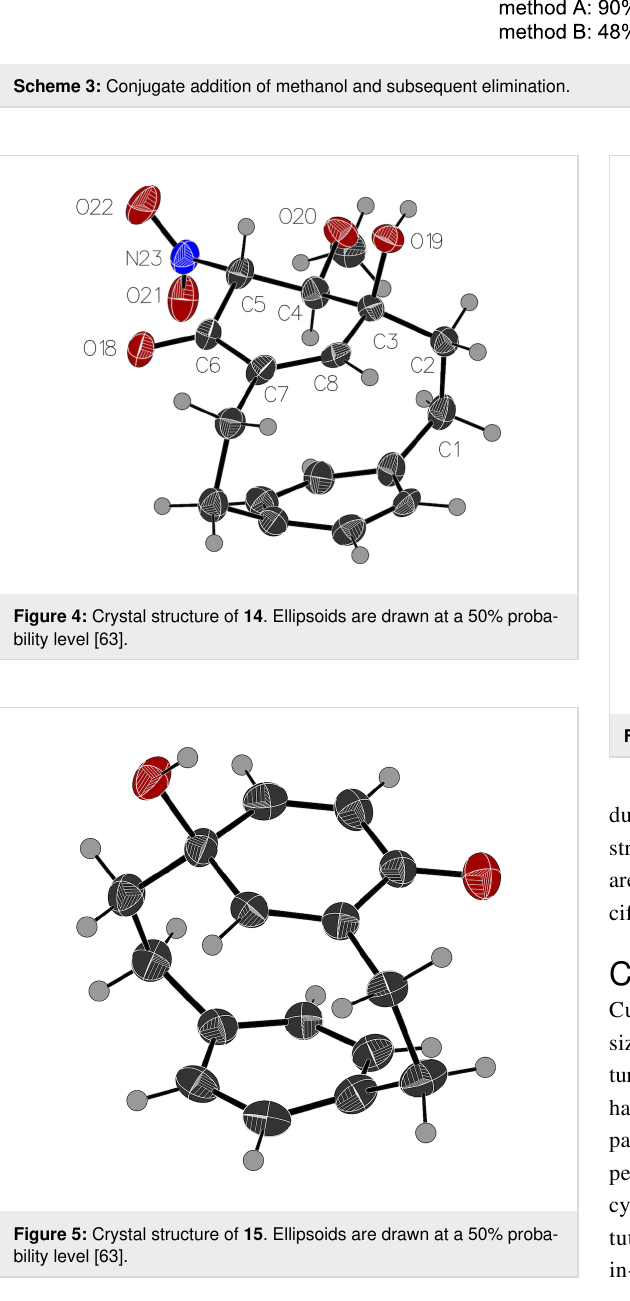
Even recrystallization can be problematic. Heating 14 leads to an elimination reaction that re-forms the initial compound 6 . It is unclear how the denitration product 15 forms. Elimination of the ether 14 to regenerate the enone 6 is straightforward, but re-